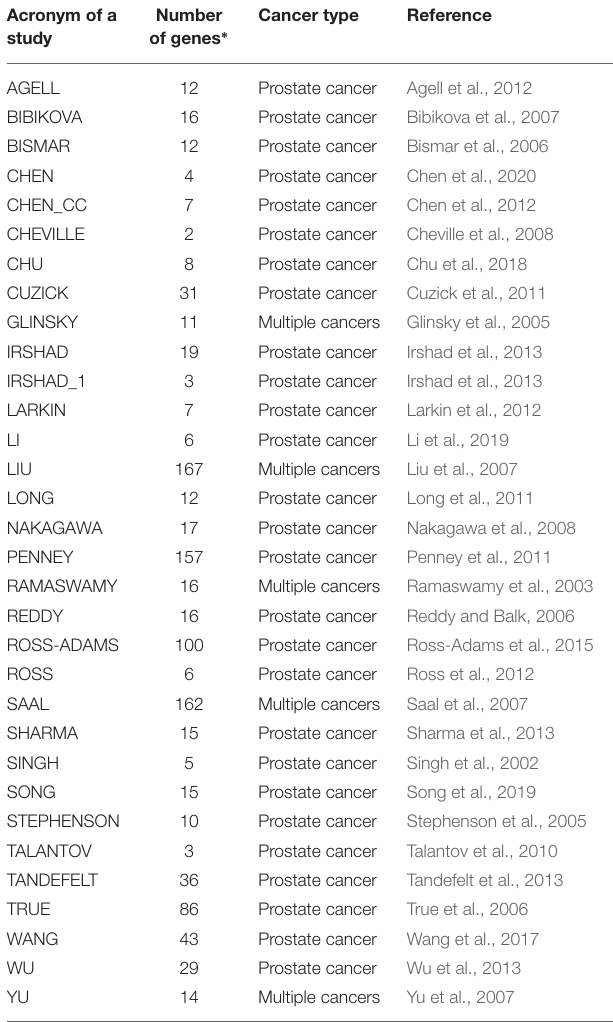
TABLE 1 | Overview of published and evaluated prognostic signatures for prostate cancer used for our